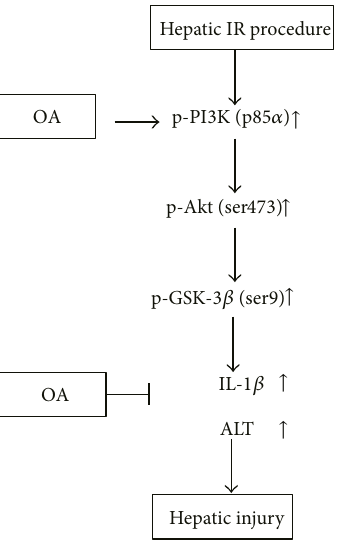
Figure 7: Proposed schematic flow of OA’s role in attenuating hepatic IR injury. IR procedure induces activation of PI3K cascades and then results in increases in IL-1 𝛽 and ALT in the serum. OA can further activate these molecular changes at the PI3K/Akt signaling pathway and results in the decreased serum ALT activity and IL-1 𝛽